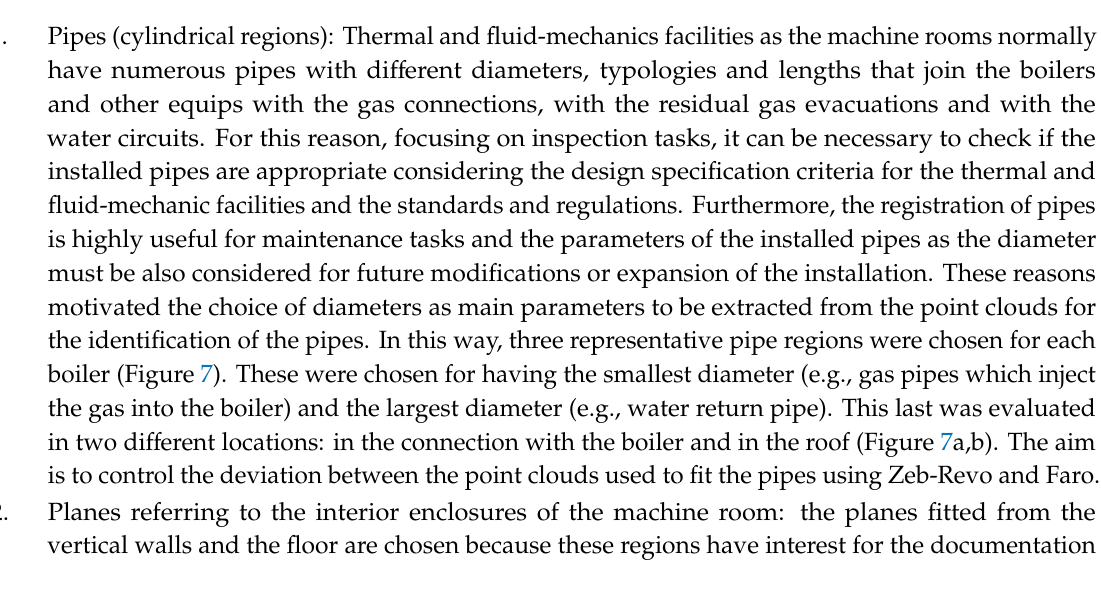
Figure 5. Dataset I: four point clouds obtained and aligned with Faro ( a ). Dataset II: point cloud obtained with Zeb-Revo ( b ). Dataset I: segmented point cloud to appreciate the distribution of facilities using Faro. ( c ). Dataset II: segmented point cloud to appreciate the distribution of facilities using Zeb-Revo ( d ). Table 2. Standard deviation of the RANSAC-based sphere fitting to align both datasets in a global CRS. SD (m) Sphere Zeb-Revo Faro ± 0.0064 ±